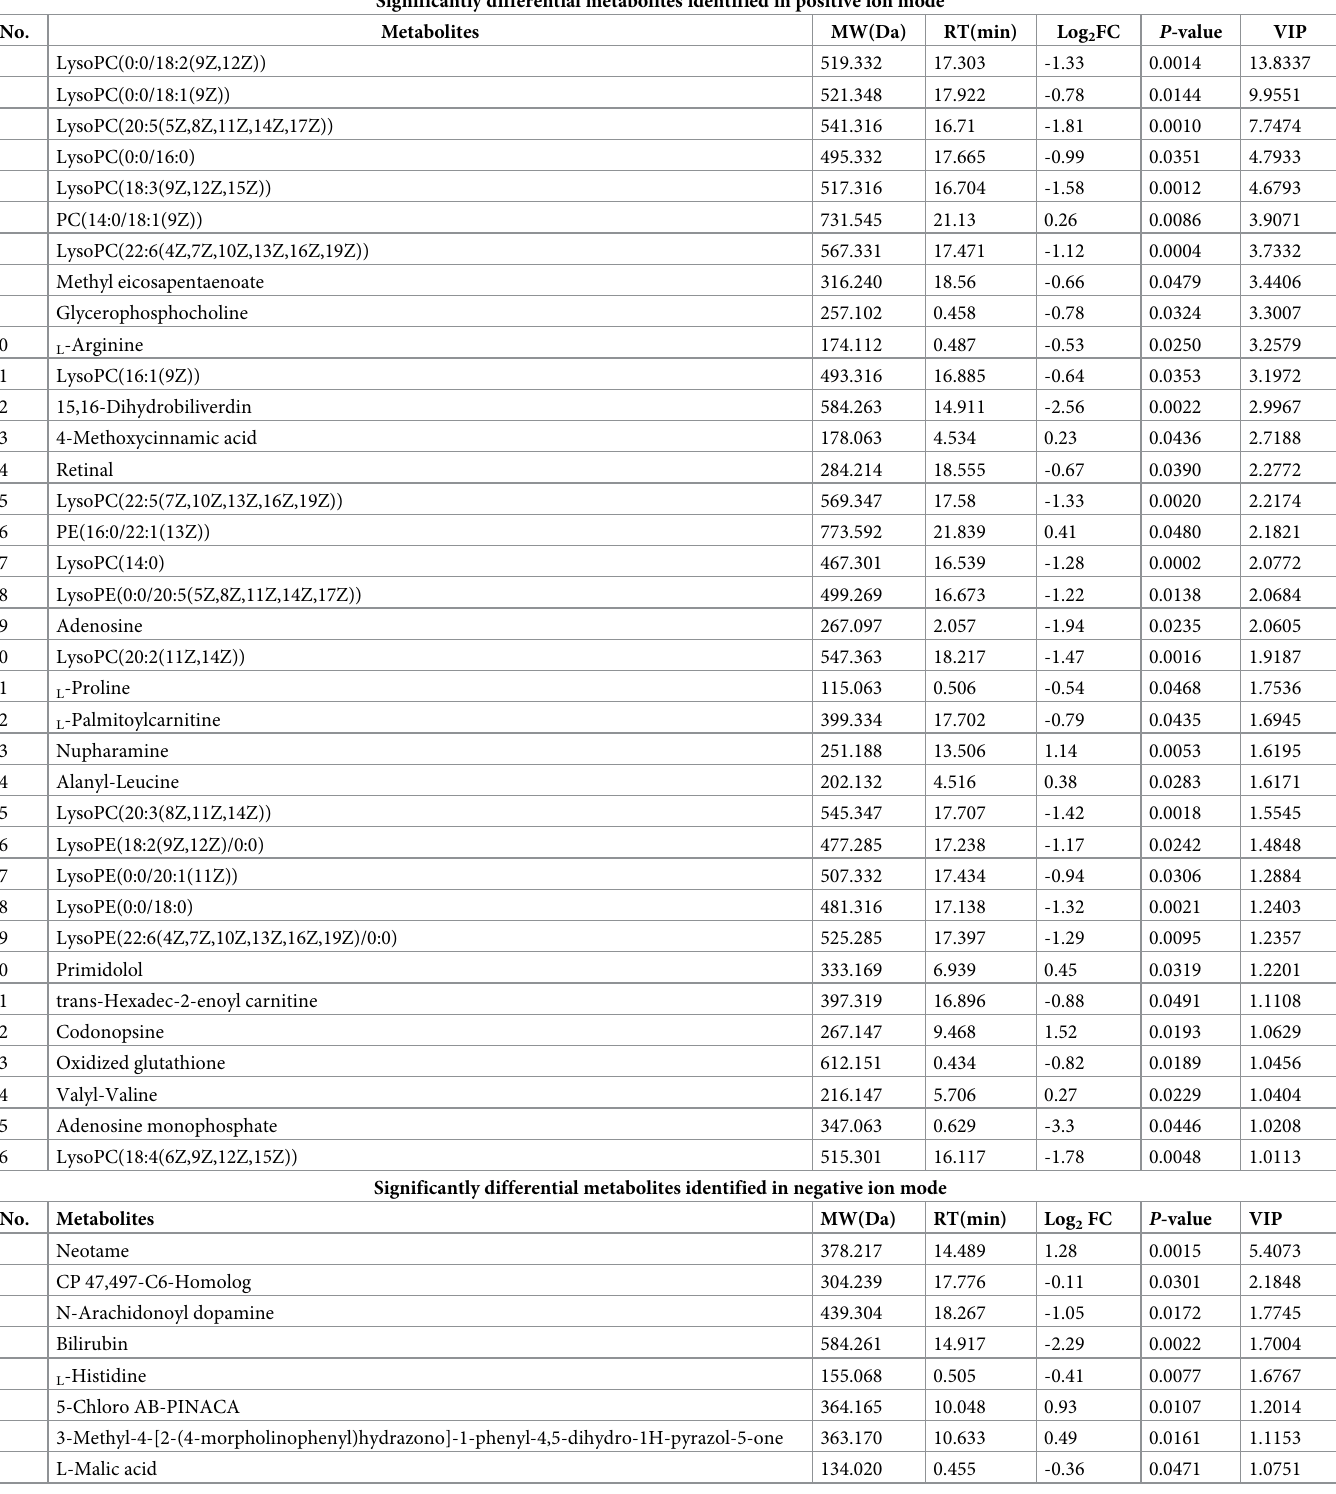
Table 2. Significantly differential metabolites for 20 prawns between fast-growing and slow-growing